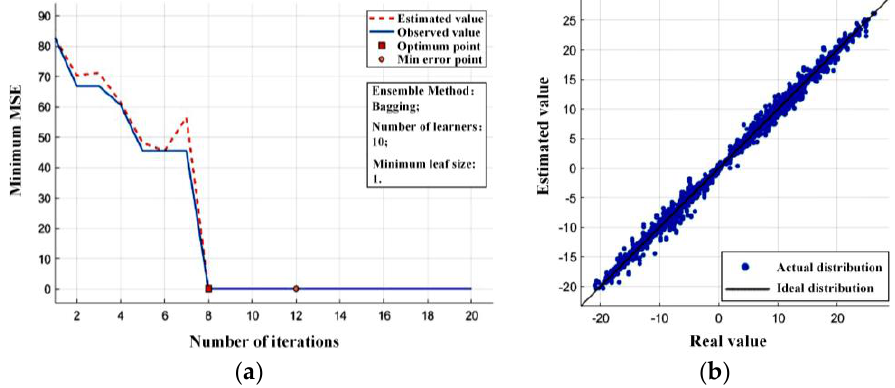
Figure 6. Machine learning effect of shoulder static adduction/abduction: ( a ) iterative training process with training set; ( b ) verification result of test set.